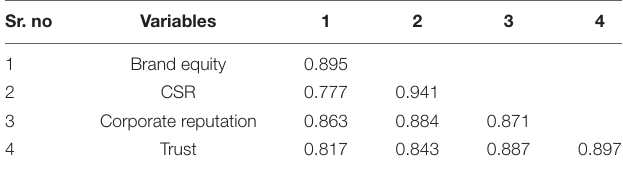
TABLE 3 | Discriminant validity of